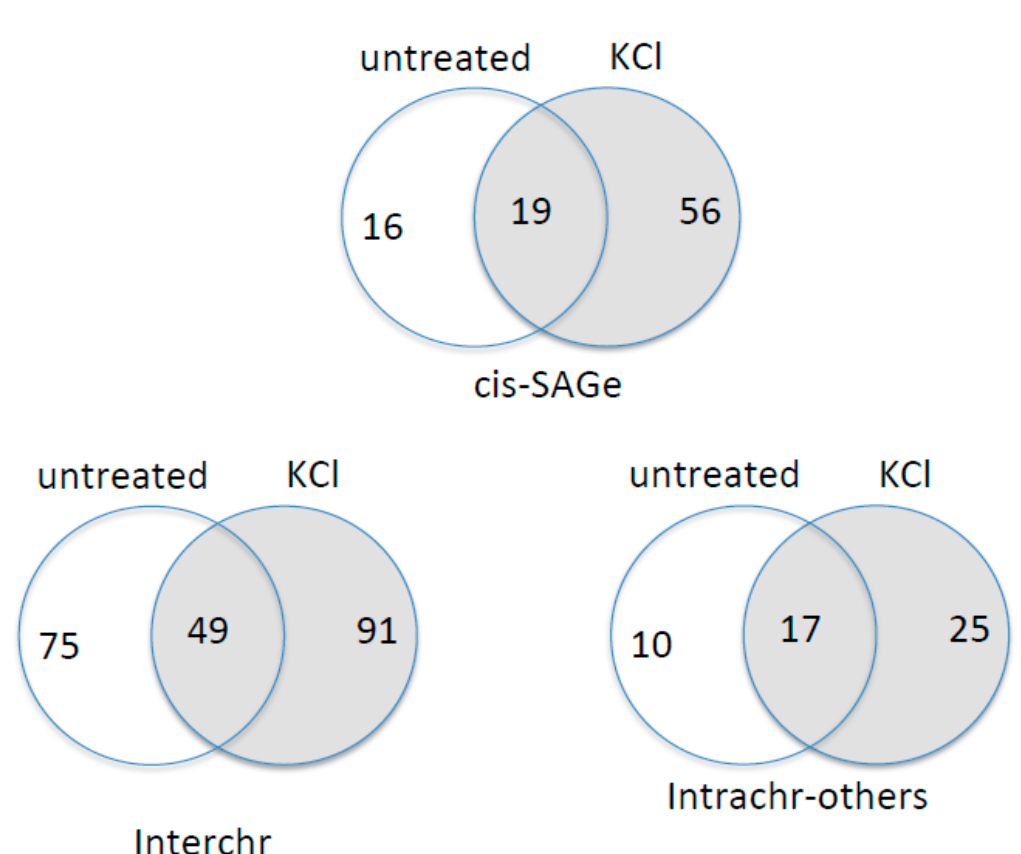
Figure 7. RNA-Seq analyses of chimeric RNAs with or without KCl-induced osmotic stress. Chimeric RNAs were grouped into three categories: cis-SAGe, Interchr, and Intrachr-others. Venn grams demonstrate the common and unique chimeric RNAs in each sample group.